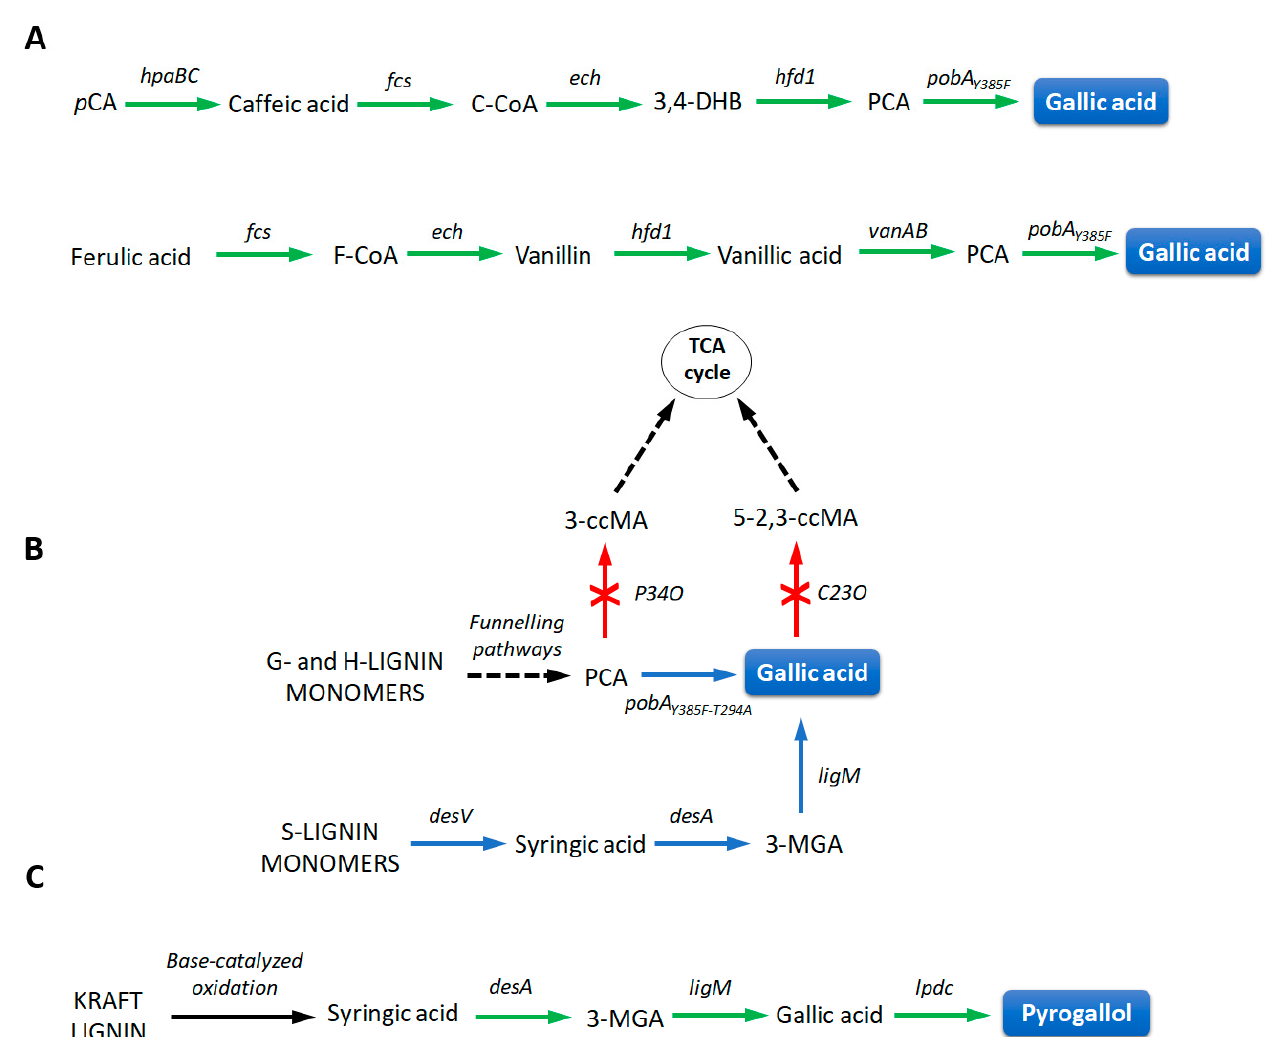
Figure 8. Scheme of gallic acid production from ( A ) engineered E. coli RARE [121] and ( B ) R. opacus PD630 [122], and of pyrogallol production from ( C ) engineered E. coli DH1 [74]. Encoding genes: hpaBC , two-component flavin-dependent monooxygenase; fcs , feruloyl-CoA synthetase; ech , enoyl- CoA hydratase/aldolase; hfd1 , aldehyde dehydrogenase; pobA , p -hydroxybenzoate hydroxylase; vanAB , vanillate demethylase; desV , aldehyde hydrogenase; desA and ligM , THF-dependent O - demethylases; P34O , protocatechuate 3,4-dioxygenase; P23O , putative catechol 2,3-dioxygenase; lpdc , decarboxylase. pCA, p -coumaric acid; C-CoA, caffeoyl-CoA; 3,4-DHB, 3,4-dihydroxybenzoic acid; F-CoA, feruoyl-CoA; 5-2,3-ccMA, 5-carboxy-2,3-dihydroxymuconate 6-semialdehyde; 3ccMA, 3-carboxy-ccMA; 3-MGA, 3-methoxygallate. Black arrows show the endogenous pathway; green arrows show overexpressed pathways; blue arrows show chromosomal inserted pathways; red crossed arrows identify deleted pathways; dashed arrows show additional multi-step pathways. 3,4-Dihydroxyphenyl-L-alanine (L-DOPA) is the precursor of dopamine and one